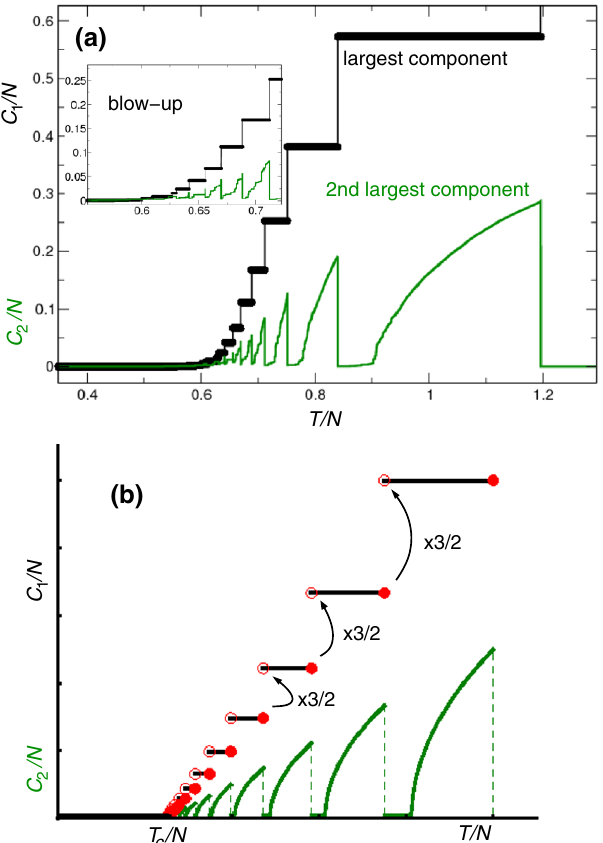
FIG. 2. The continuity of the transition and infinitely many discontinuities in any neighborhood of the onset of the phase transition are compatible. (a) Staircase shape of the multiple- discontinuous stochastic process for N ¼ 655 360 (single real- ization for l ¼ 3 ); inset: blowup of the transition region. The (black curve), and evolution of the two largest components, C 1 C (green curve), are displayed. The stairs follow approximately 2 C ! 3 , already established for small system sizes. the rule, C 1 1 2 The second largest component exhibits multiple continuous transitions. Mergers with the largest component involve break- . In the thermodynamic limit, the process shows downs of C 2 infinitely many discontinuous jumps but is still continuous according to the continuity property (fc) described in the text. Panel (b) shows a sketch of the staircase process for N ! 1 , ¼ T c =N by infinitely characterizing a continuous transition at t 1 many